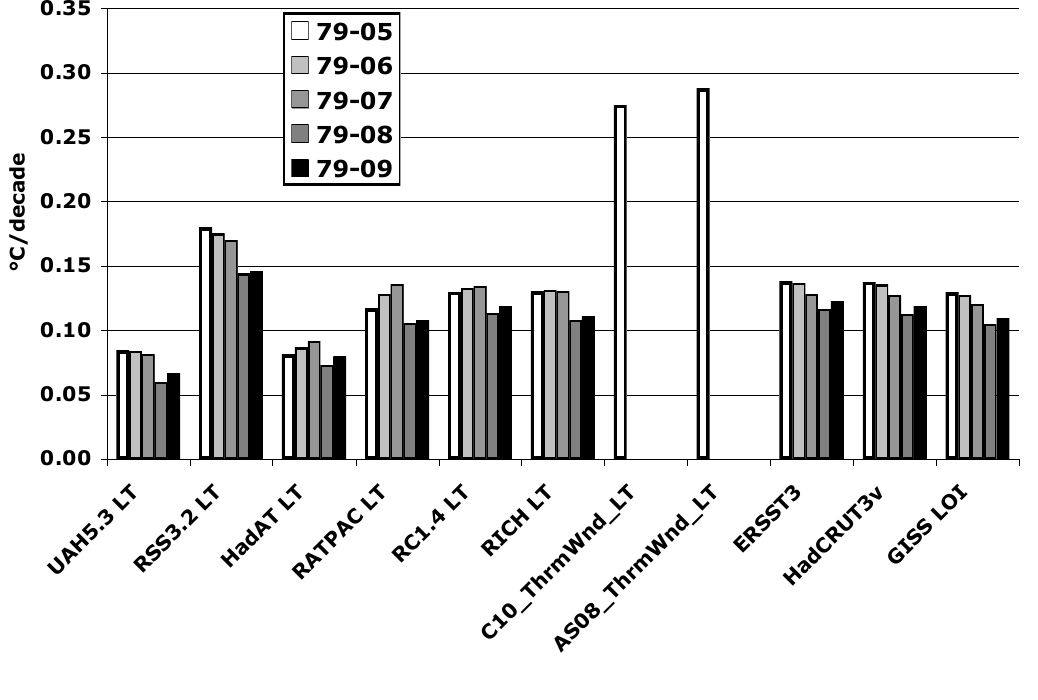
Figure 3. Trend magnitude for T trends begin in 1979 and end in the year